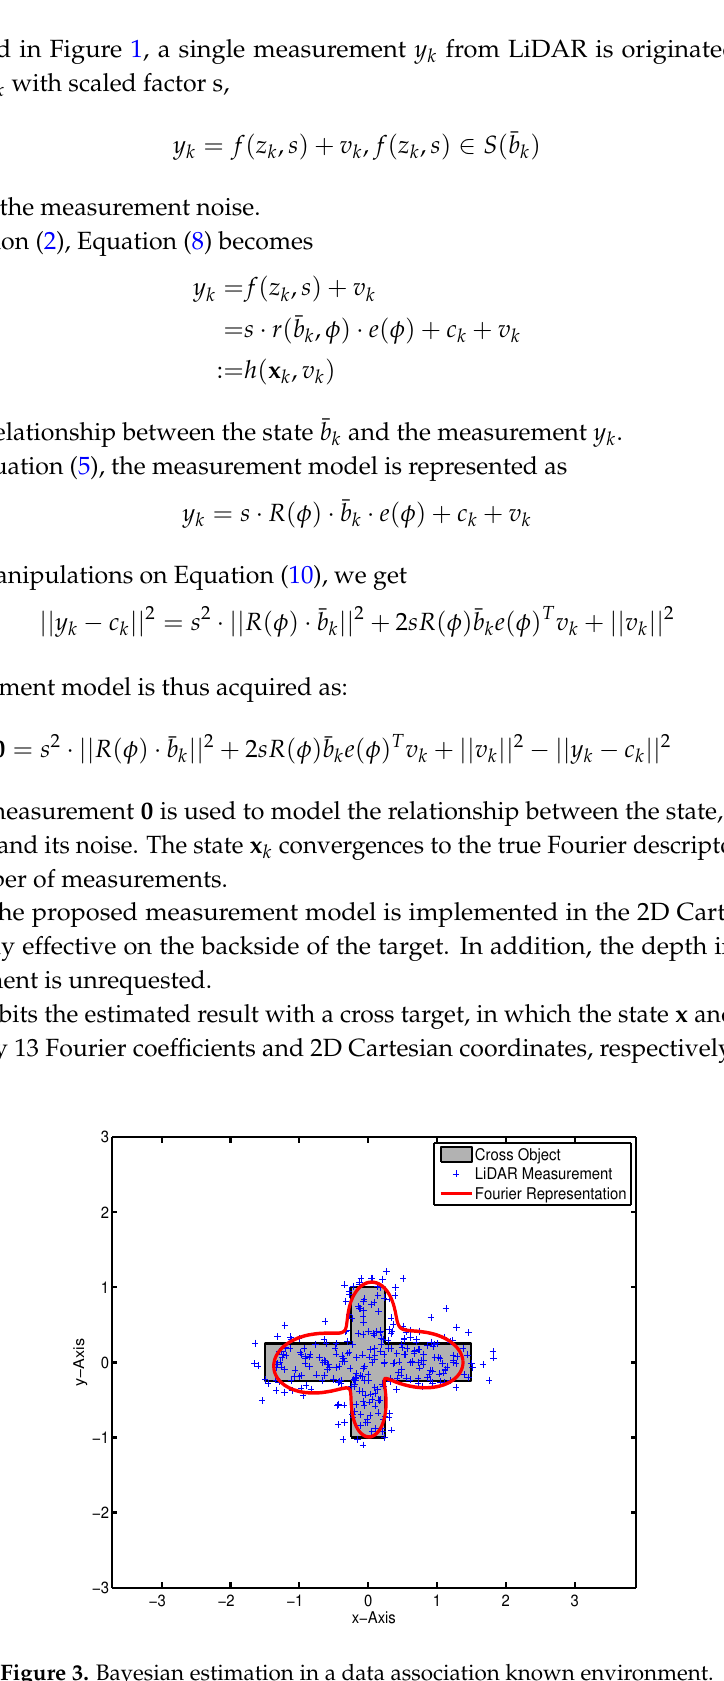
Figure 3. Bayesian estimation in a data association known